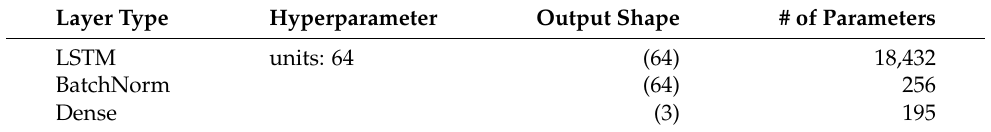
Table 4. Overview and details of the LSTM architecture.The output shape is given for one batch.